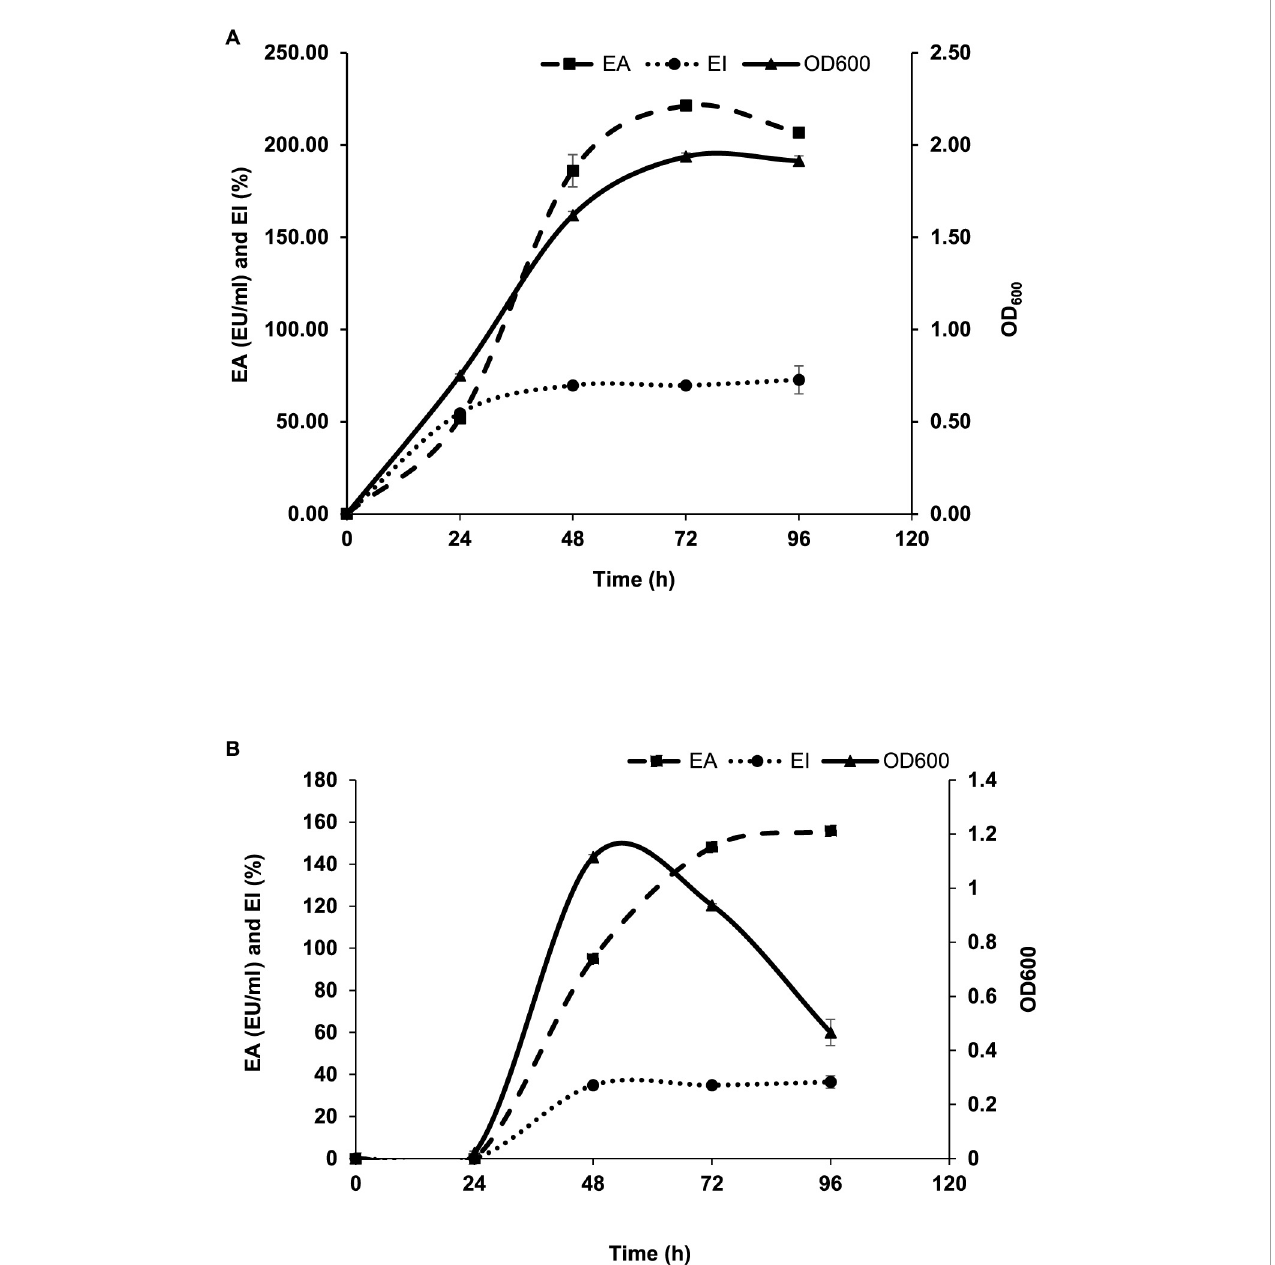
FIGURE3 (A) Effect of LB medium on growth and BE production ability of Parapedobacter indicus. (B) Effect of MSM amended with 1% glucose medium on the growth and BE production ability of Parapedobacter